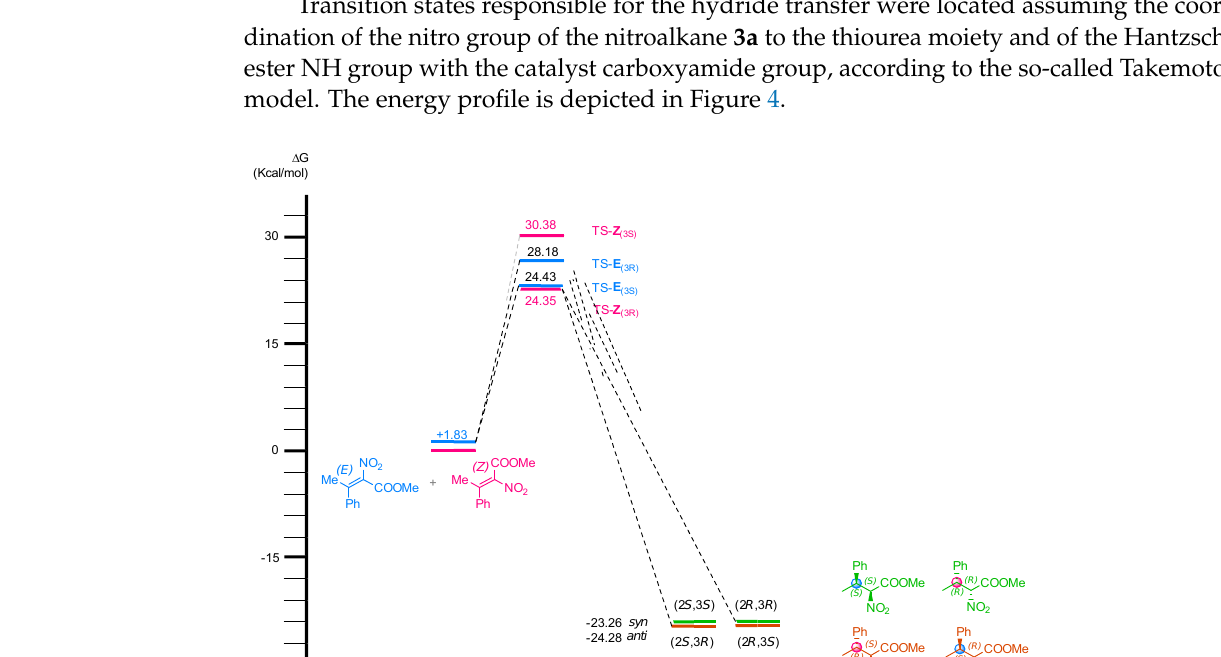
Figure 5. Transition states formed by the E - isomer of nitroacrylate 3a. The blue spheres represent the nitrogen atom of the nitro group of nitroalkane 3a and of the thiourea catalyst A , the yellow one represents the sulfur atom of the thiourea moi- ety, and the red spheres represent the oxygen atoms of nitro and ester groups of com- pound 3a, and of the carboxyamide group of the catalyst. The pink sphere represents the tert -butyl groups of the Han tz sch ester, carbon atoms are grey and hydrogen atoms are white. The broken lines showed the H-bonding interaction between the nitro group of 3a and the thiourea moiety of the catalyst, and the transfer hydride between Han tz sch ester and carbon C 3 of the nitroole fi n. According to the calculations, among the two transition states originating from Z -ole- fin, TS- Z -( 3R ) is the lowest in energy and would lead to the formation of the final product with a R- configuration at the C 3 carbon, in agreement with the experimental data. However, the ( Z ) isomer was found to be very poorly reactive, while, as established in NMR analysis, the more reactive isomer is the ( E )-nitroacrylate, that, according to the calculations should preferably afford the (S) enantiomer at C 3 carbon of compound 4a . These findings are in contrast with the experimentally established absolute configuration ( R ) for the major enan- tiomer derived from the reaction of the E isomer of 3a . Therefore, we can conclude that, at